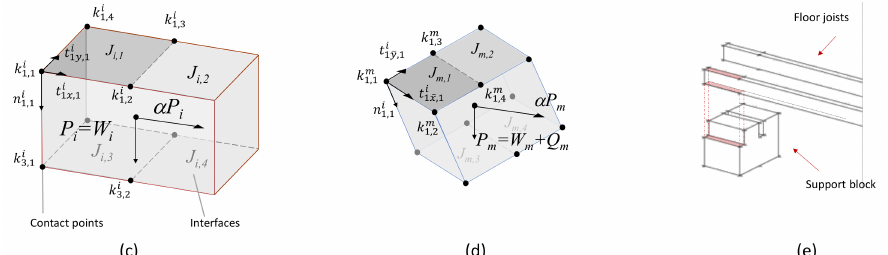
Figure 6. The numerical model of the castle: ( a ) exterior north-east view with labeled façades; ( b ) interior south-east view; ( c ) a sample of the adopted rigid block model and loading condition. The block type “ i " presents six interfaces J i ,1 − 6 of four contact points k i each. Normal forces n i and two j ,1 − 4 j ,1 − 4 shear forces ( t i , t i ) act at each contact point along the local block axis. The self-weight W m jx ,1 − 4 jy ,1 − 4 and the live loads α W m are applied at the centroid of the block. ( d ) A voussoir block type; ( e ) details of the rigid block shapes for the rigid blocks supporting the floor joists.